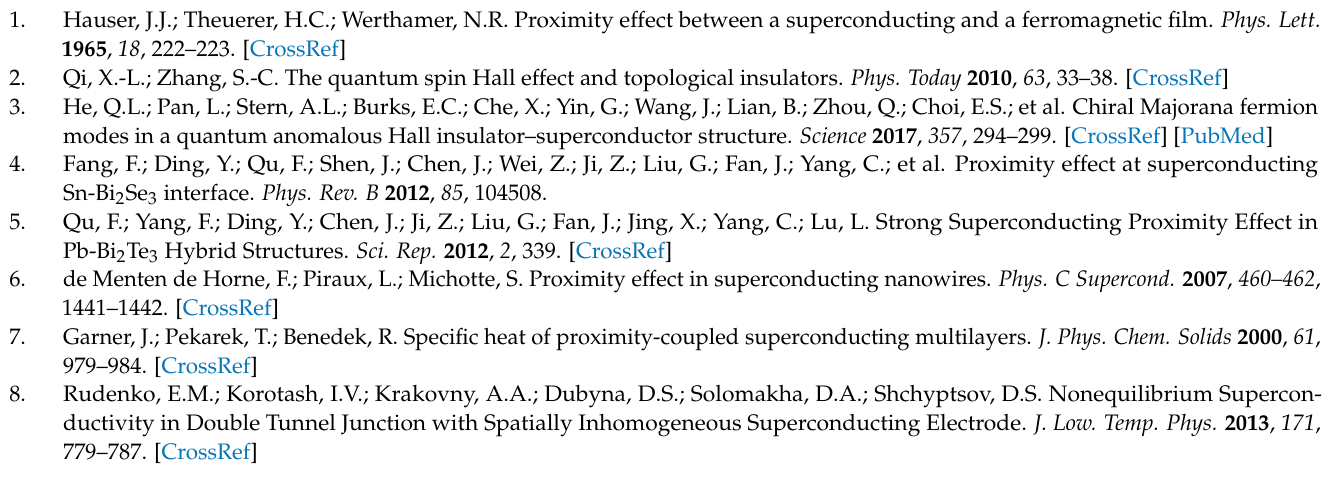
Figure S2: Temperature dependence of magnetization; Figure S3: The isothermal magnetization M(H a ) loops; Figure S4: The M(H a ) loops measured using protocol 0 Oe → +900 Oe → 0 Oe field; Figure S5: Temperature dependence of ZFC magnetization of Sn r Pb 1-r bimetallic